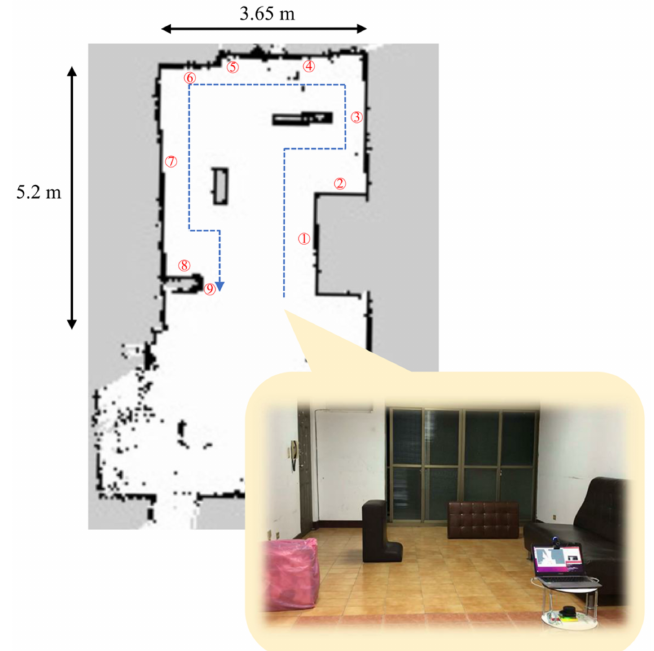
Figure 32. Mapping results of first environment, number 1–9 mean the length of each